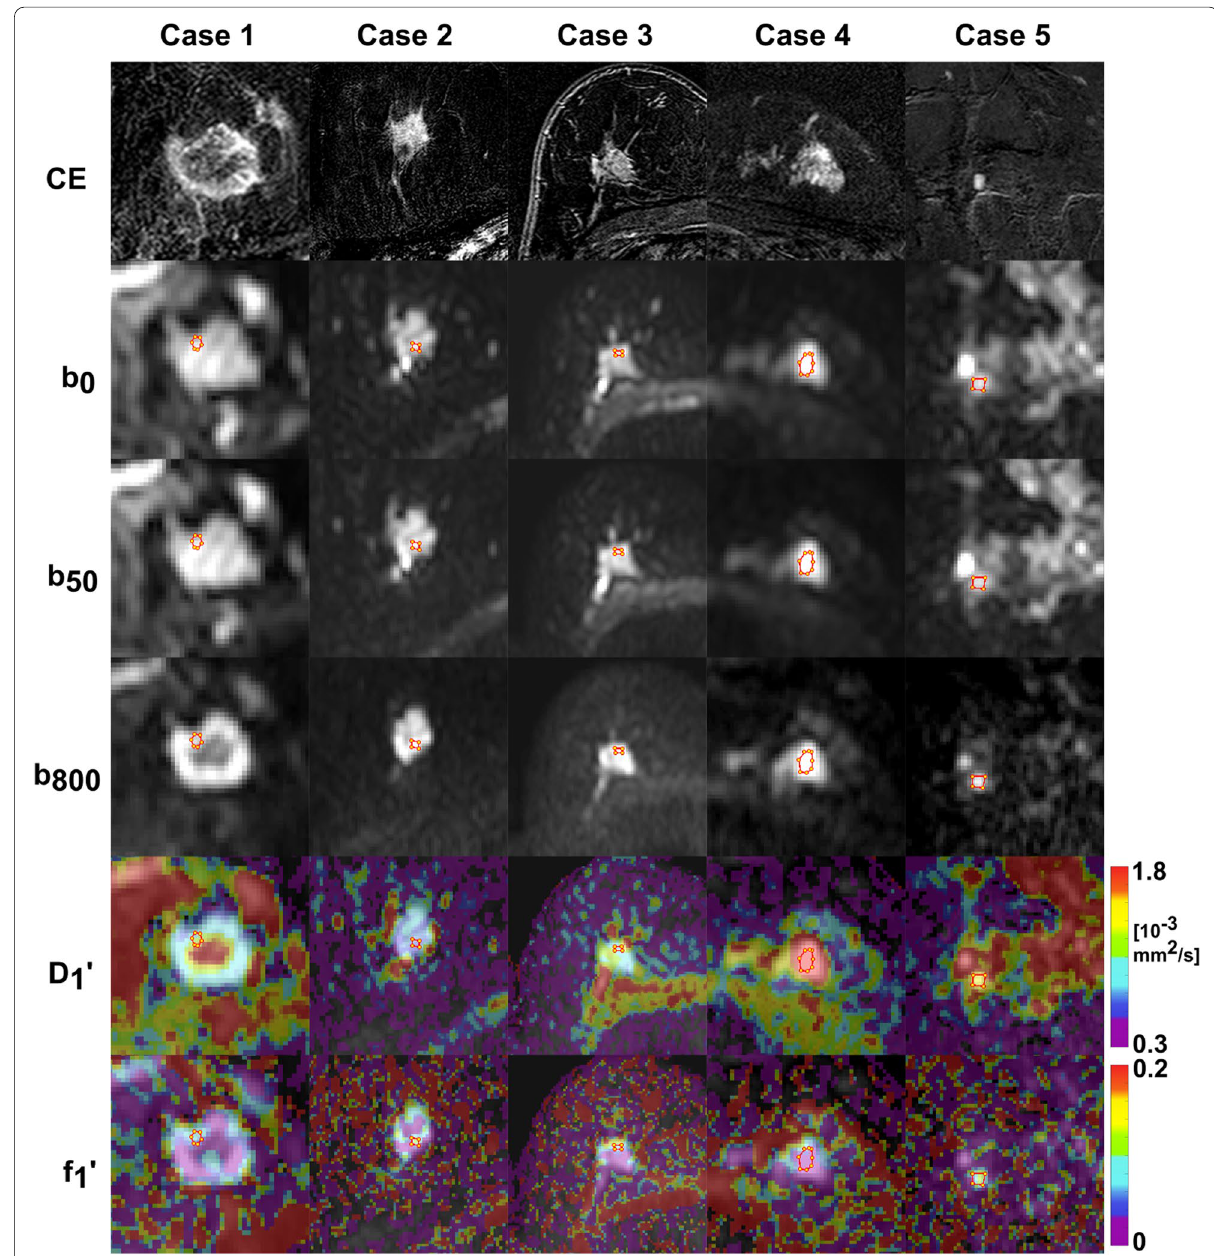
Fig. 1 Examples of axial diffusion-weighted imaging and intravoxel incoherent motion-parameter maps of breast lesions. From top to bottom, contrast-enhanced T1-weighted subtraction images (CE), original trace-weighted diffusion-weighted (DW) images with b 0, 50, 800 s/mm 2 , and = D 1 ′ and f 1 ′ colour-coded maps overlaid to DW images with b 800 s/mm 2 are given together with the used hot spot regions-of-interest (HS-ROIs). = Invasive ductal carcinoma (case 1, 2 and 3, all G3 grade) typically show D 1 ′ values between 0.6 and 1.2 10 -3 mm 2 /s in areas with maximum × hyperintensity on DW images with b 800 s/mm 2 (turquoise) and mixed f 1 ′ values with hot spot values between 0.05 and 0.15 (turquoise). In case = 1, central necrosis is present showing high D 1 ′ values (red-yellow). Hyperintense area in case 4 was histologically diagnosed as fibrous mastopathy, ductal and lobular hyperplasia showing high D 1 ′ of 2.0 10 -3 mm 2 /s (red) and low f 1 ′ of 0.01 (turquoise). Another case with fibrous mastopathy × (case 5) showed also high D 1 ′ of 1.4 10 -3 mm 2 /s (yellow) but higher f 1 ′ of ×